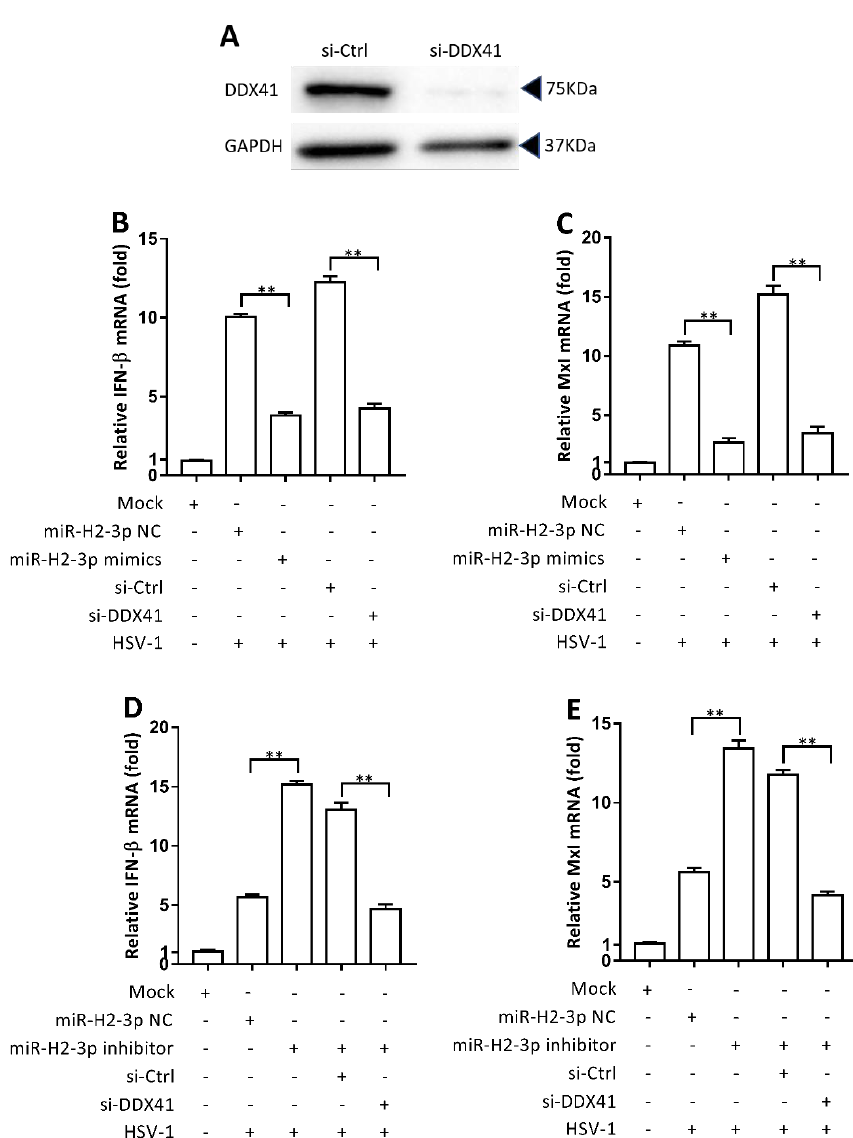
Figure 5. miR-H2-3p downregulated HSV-1-triggered IFN- β and ISG expression by targeting DDX41 directly. ( A ) THP-1 cells were transfected with siRNA (final concentration of 50 nM) for the knockdown of DDX41 or nonspecific control (si-Ctrl), as indicated. After 24 h of transfection, the effect of knockdown of DDX41 was evaluated by immunoblotting, using GAPDH as a loading control. ( B , C ) THP-1 cells were transfected with miR-H2-3p mimics or negative control (NC) (final concentration of 100 nM), siRNA against DDX41, or control (Ctrl) (final concentration of 50 nM), as indicated. After 24 h of transfection, THP-1 cells were infected with HSV-1 at an MOI of 1 or mock (Mock) for 24 h. The IFN- β ( B ) and MxI ( C ) expression levels were determined by qRT-PCR. The values were normalized to GAPDH. ( D , E ) THP-1 cells were transfected with miR-H2-3p inhibitor or miR-H2-3p NC (final concentration of 100 nM) and siRNA against DDX41 or control (Ctrl) (final concentration of 50 nM), as indicated. After 24 h of transfection, THP-1 cells were infected with HSV-1 at an MOI of 1 or mock (Mock) for 24 h. The IFN- β ( D ) and MxI ( E ) expression levels were determined by qRT-PCR, and the values were normalized to GAPDH. All data are the means ± SD ( n = 3) from one representative experiment. Similar results were obtained from three independent experiments. ** P <